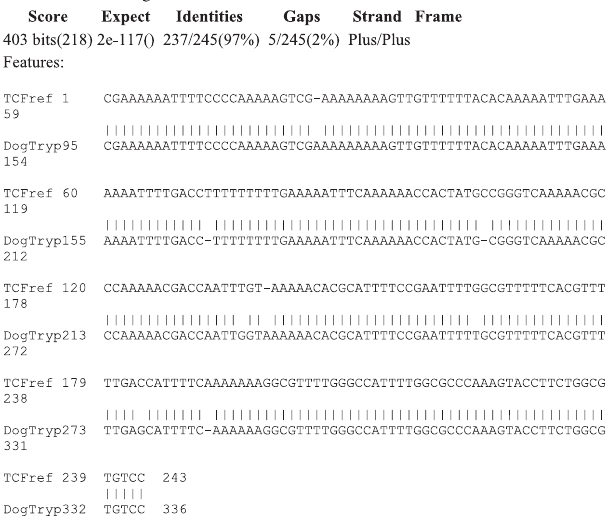
Figure 5. Comparison of the dog’s trypanosome sequence with the reference sequence published by Masiga et al. [21].